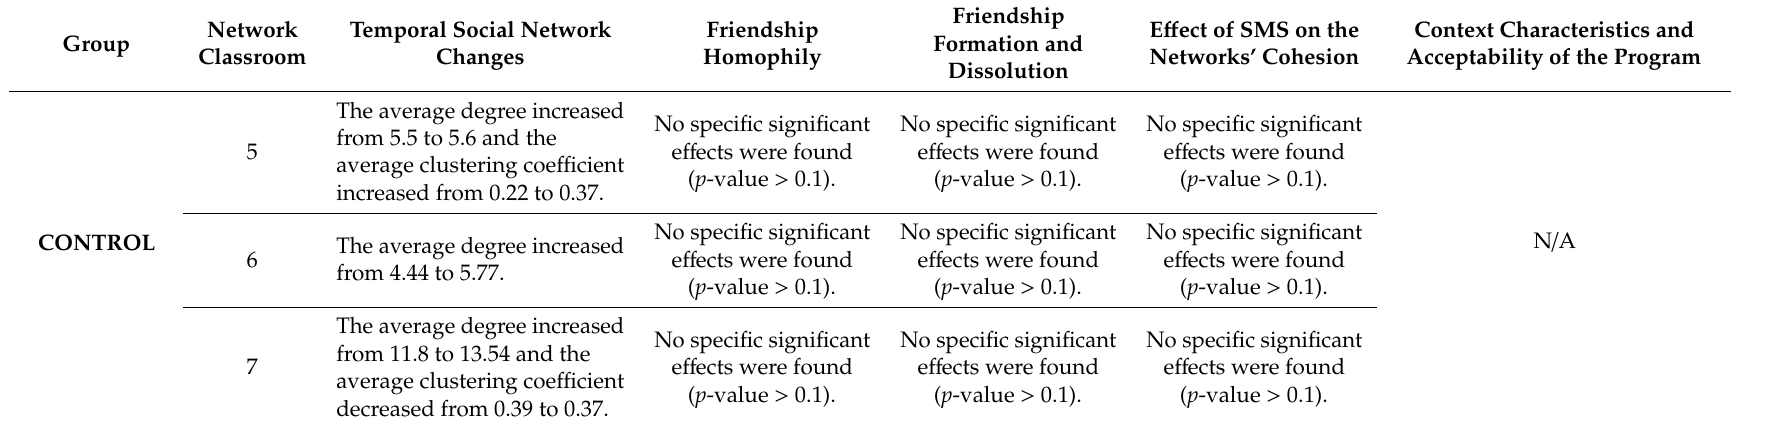
Table 4. Specific results for each control